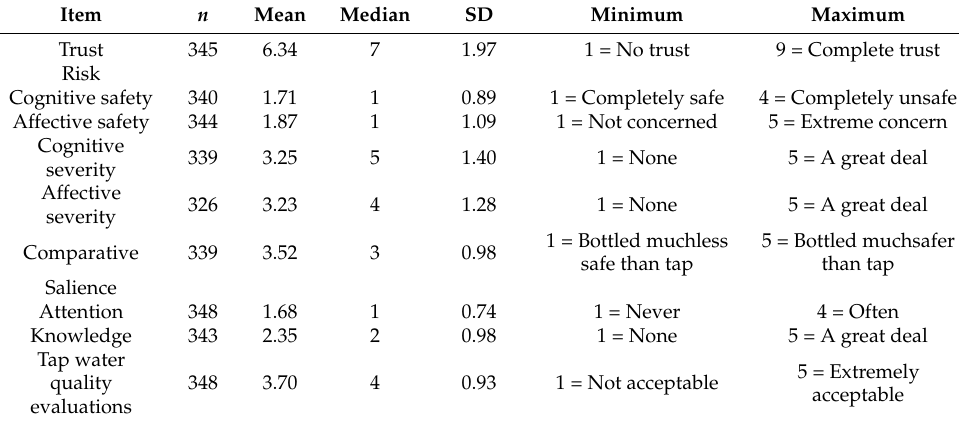
Table 2. Descriptive statistics for predictor variables. Statistics for each survey item include number of observations ( n ), mean, median, standard deviation (SD), minimum scale value (minimum) and maximum scale value